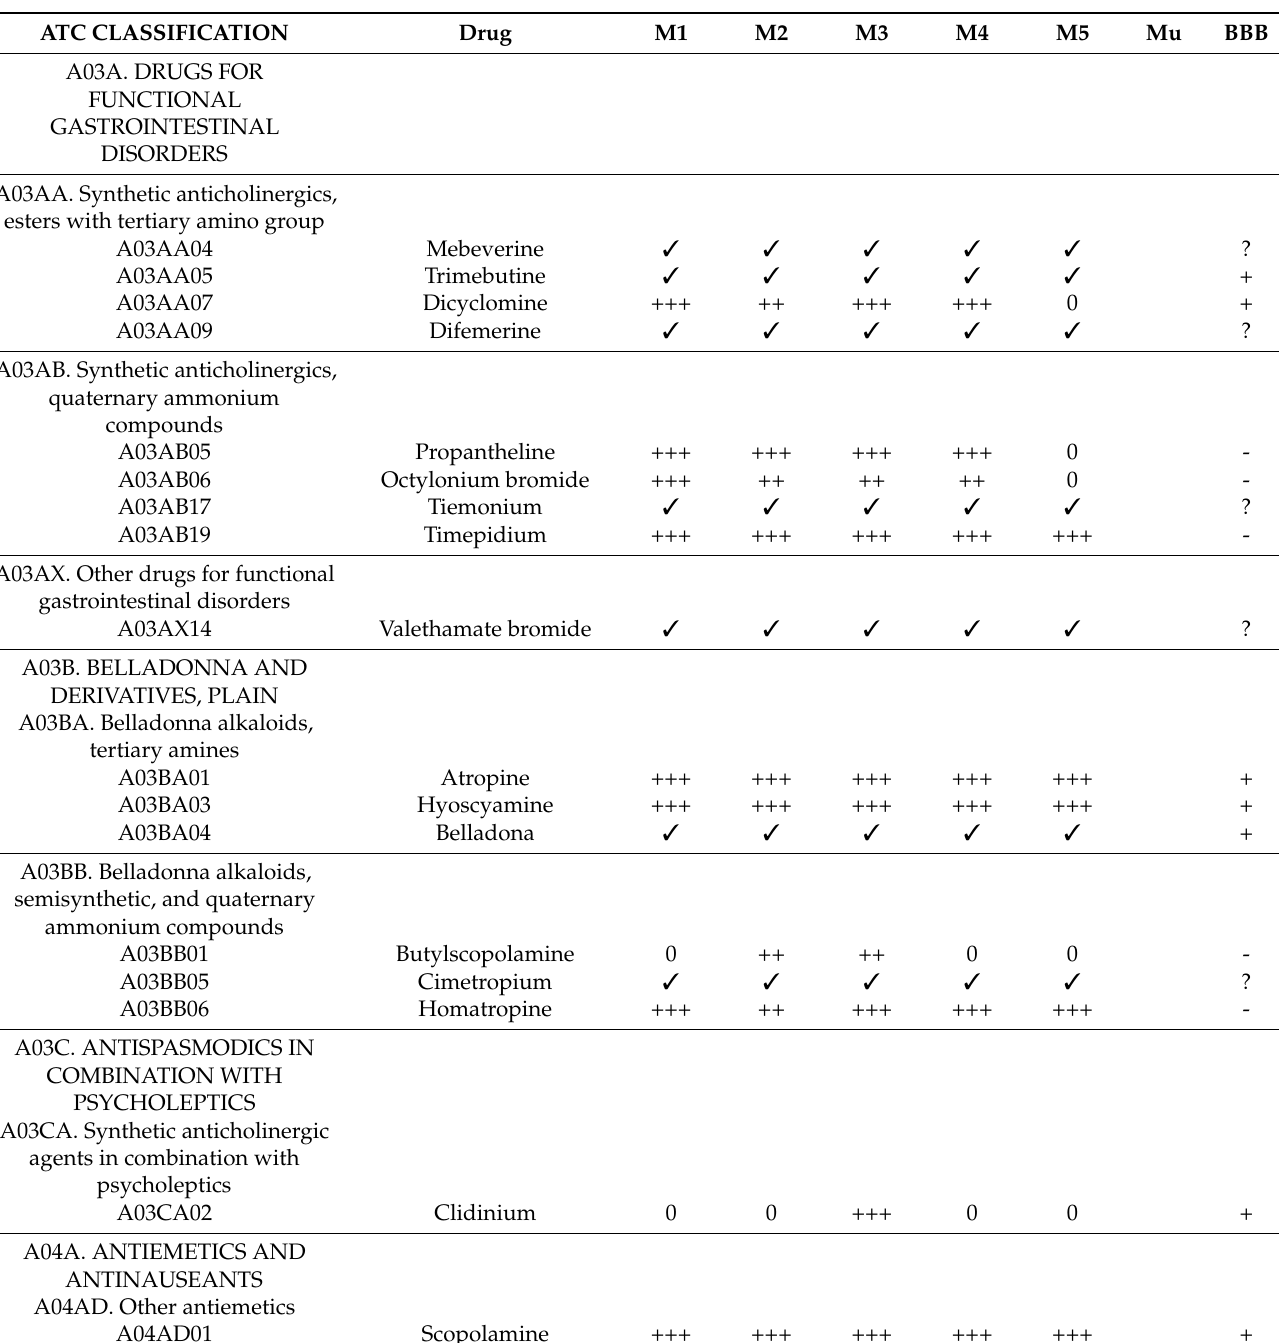
Table 5. Universal list of drugs with documented anticholinergic activity, based on objective pharma- cological data, according to ATC classification, and considering the five muscarinic receptor subtypes. ATC